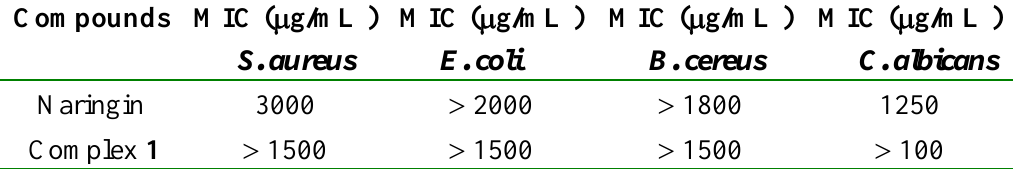
Table 3. Minimum Inhibitory Concentration (MIC) of naringin and complex 1 by the Agar Dilution method.